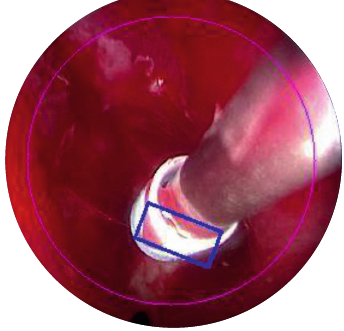
Figure 6. Object tracking by visual